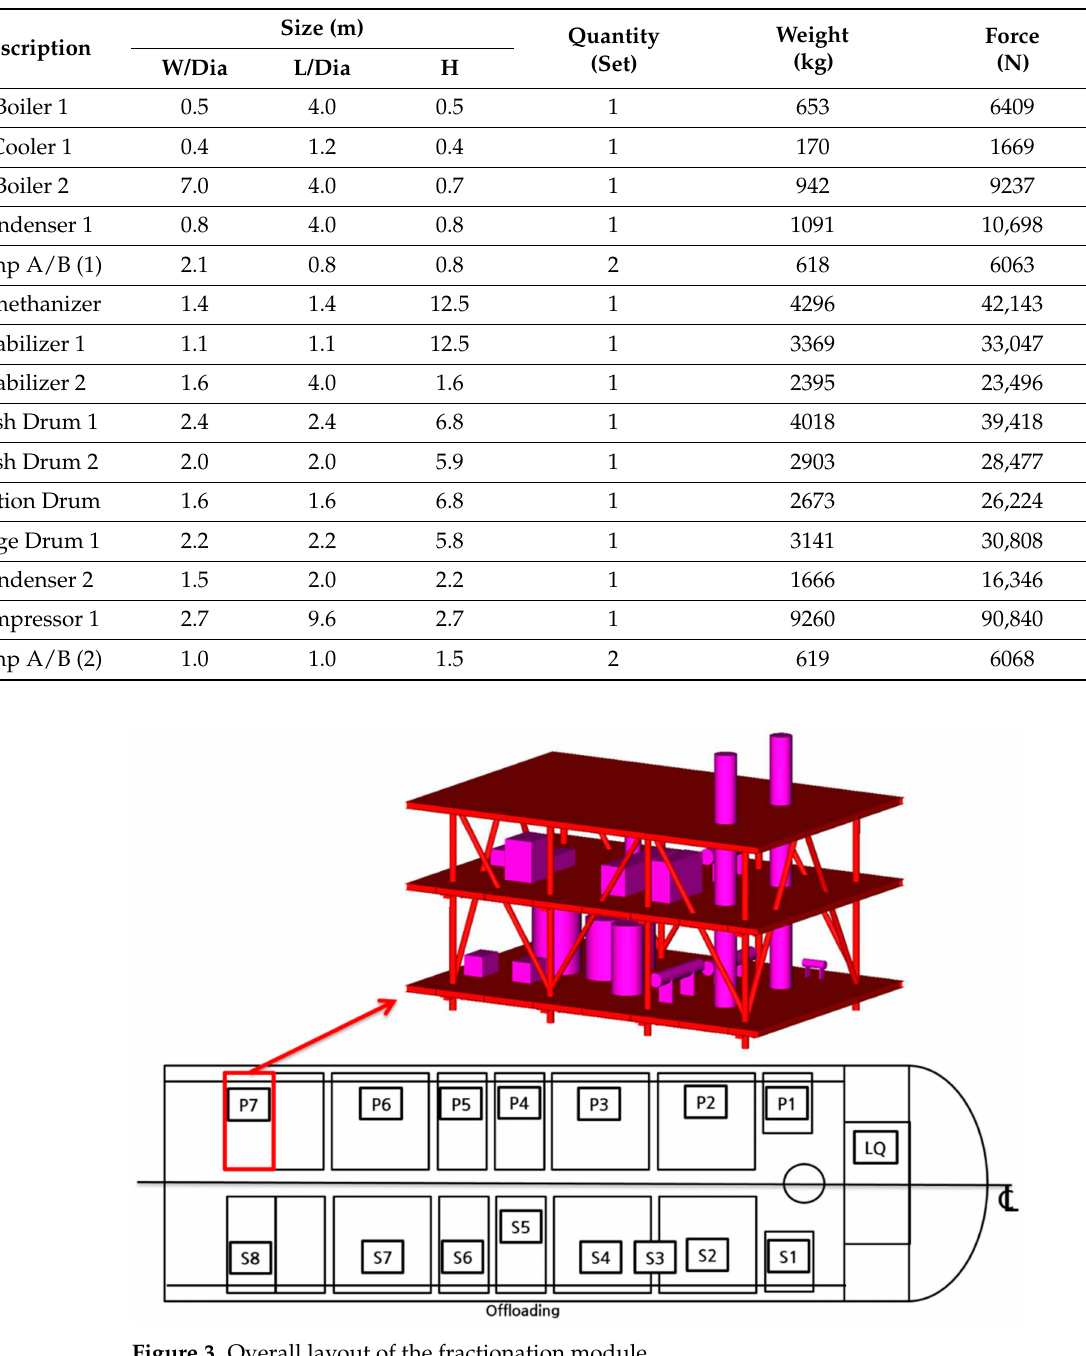
Table 1. Maintenance equipment list.